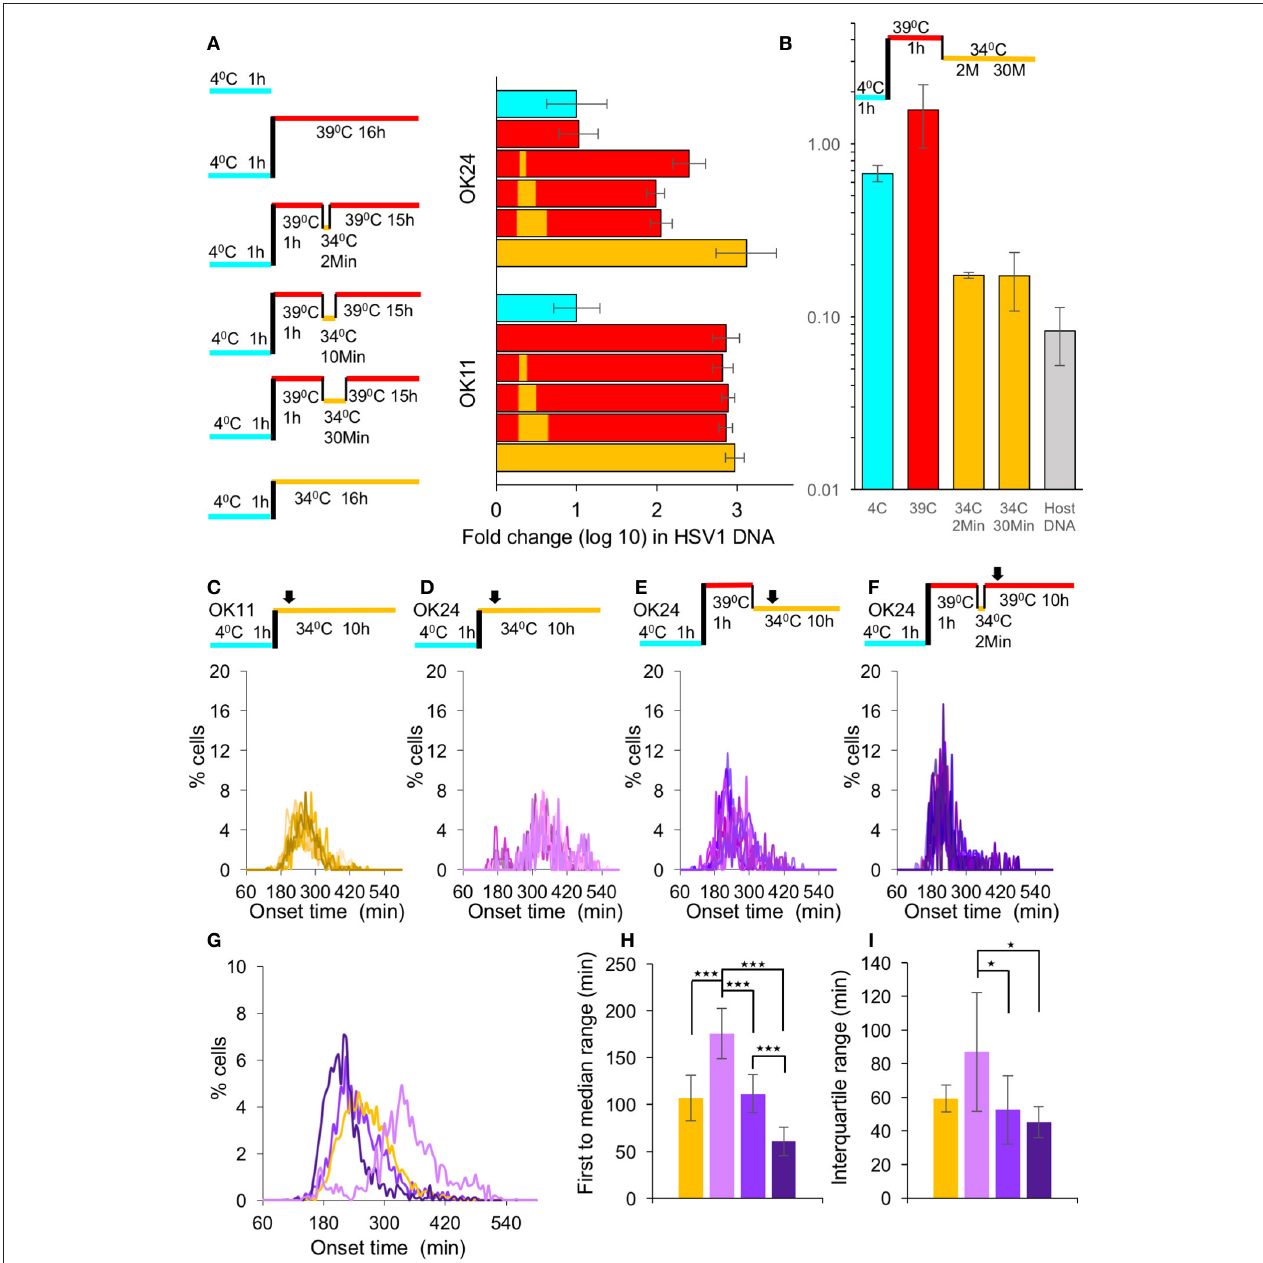
FIGURE 3 | Synchronous nuclear entry does not increase simultaneous gene expression. (A) Left panel—A schematic representation of the six different temperature conditions (On ice—light blue, 34 ◦ C—yellow and 39 ◦ C—red) in which the viral DNA levels were measured. Right graph—Cells were infected with either OK11 or OK24 fold-change differences of viral DNA levels between the different conditions (color-coded as the left panel), as measured by qPCR; each condition was repeated three times. Error bars represent the standard error. (B) Cells were infected with ts viral recombinant at MOI 20. At different stages of the infection conditions of infection are illustrated above the graph, color coded as (A) , the cells were collected. The amount of capsid protected viral DNA in the cells divided by the total amount of viral DNA at each point are presented. An average of two technical replicates (each measured by qPCR). Error bars represent the standard error. (C–F) All infections were done at MOI 20. Histograms present the percentage of cells at each time point, that initiated expression (binning every 5min). At least eight wells from at least two experiments done on different days were plotted. The infection conditions are schematically illustrated above each graph. Arrows represent imaging starting time ( ∼ 1h from last temperature shift). (C) Cells were infected with OK11 recombinant virus at 34 ◦ C. (D) Cells were infected with OK24 recombinant virus at 34 ◦ C. (E) Cells were infected with OK24 recombinant virus at 39 ◦ C for 1h and shifted to 34 ◦ C for the rest of the experiment. (F) Cells were infected with OK24 recombinant virus at 39 ◦ C for 1h and shifted to 34 ◦ C for 2min. (G–I) A comparison between the onset times of expression for the infection presented in (C) (yellow), (D) (light purple), (E) (purple), and (F) (dark purple). (G) The average histograms for each condition were plotted. (H) The time between the first cell onset of expression to the median cell onset (first to median range) was plotted for each condition. (I) The interquartile range was plotted for each condition. (G–I) Error bars represent the standard deviation among the different wells. * P < 0.05, *** P < 0.001 by student T -test.